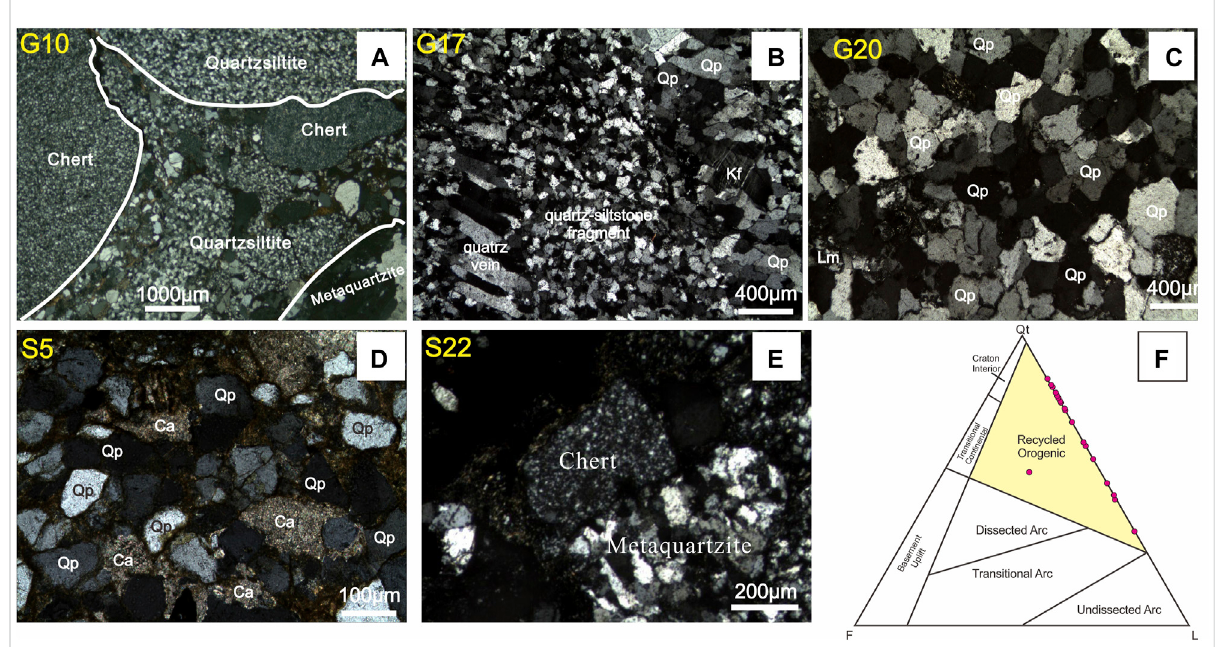
FIGURE 4 (A – C) Representative cross-polarized lightphotomicrograph ofgravelsamples. (D,E) Representative cross-polarized lightphotomicrograph of sandstonesamples. (F) Qt-F-Lternarydiagramdisplaystherelativeabundanceofframeworkgrainsinsandstone,Qt:totalquartz,F,feldspar,L: lithic rock fragments, Ca: carbonate